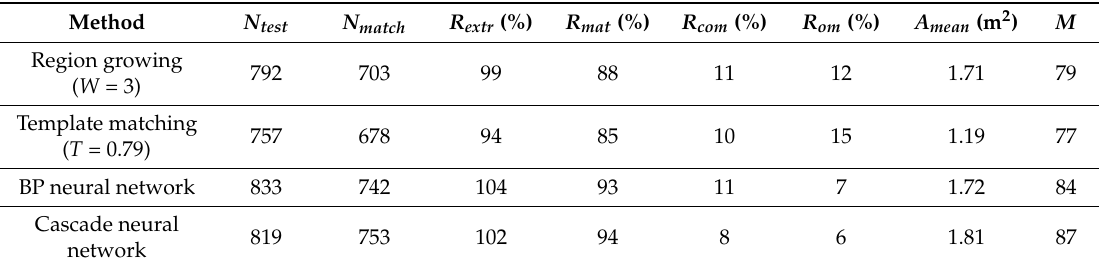
Table 1. Detection results for test area